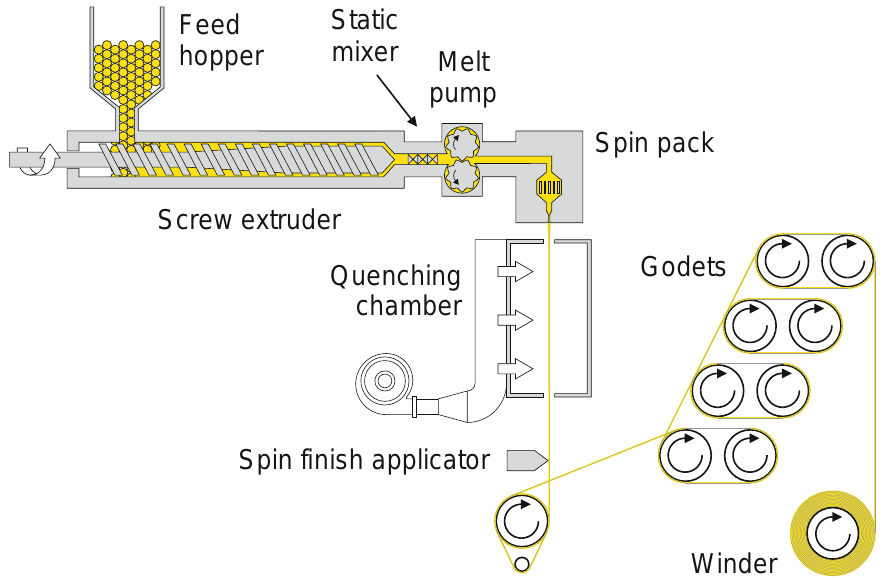
Figure 1. Schematic assembly of a melt-spinning line. By way of illustration, the polymer is represented in yellow.